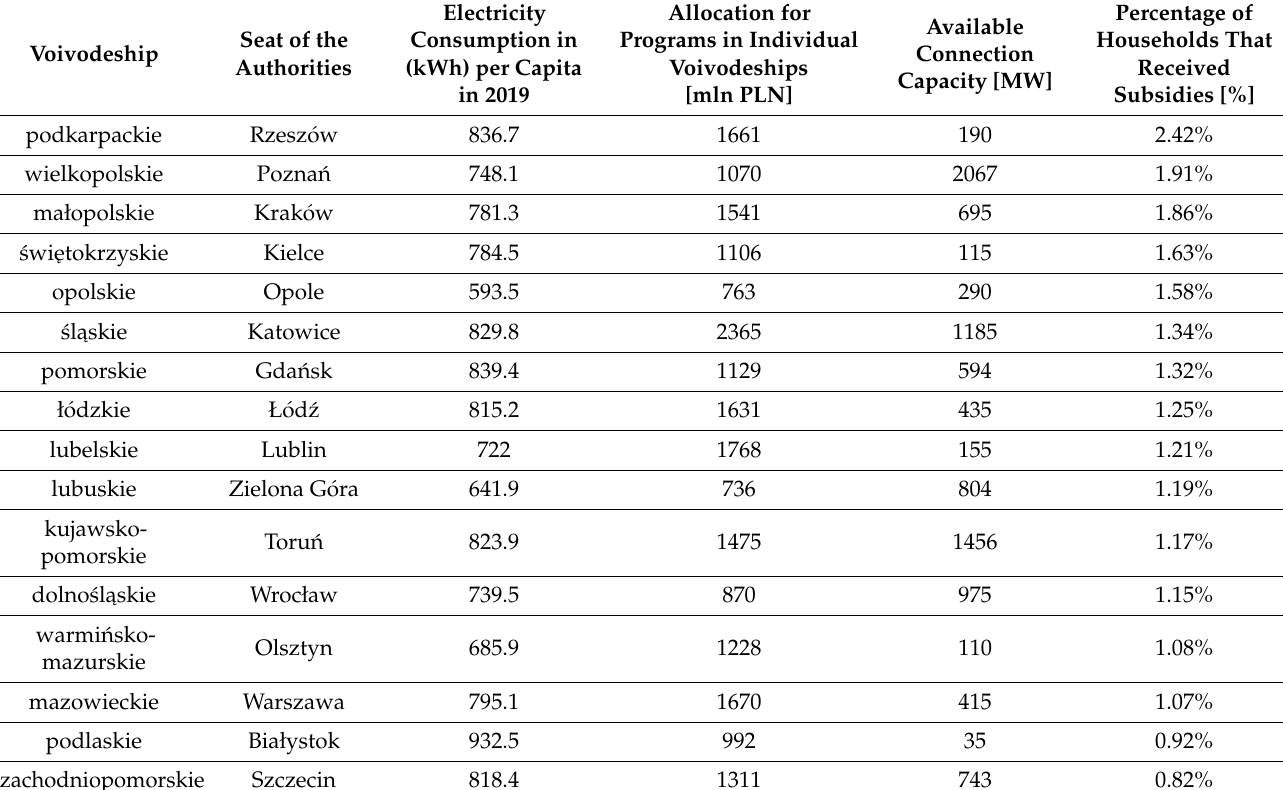
Table A1. The input data for